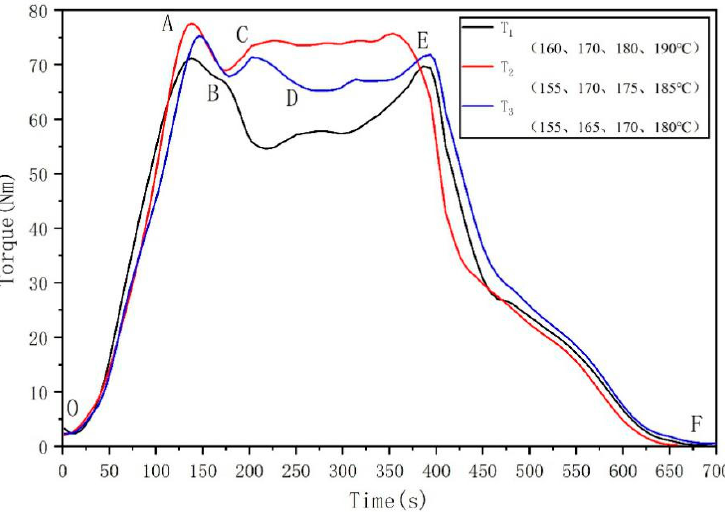
Figure 4. The influence of temperature on the extrusion torque change. OA section: When solid material is added, the torque increases rapidly. AB section: The material is compressed, and the torque drops to point B. BC section: The material begins to soften or melt, and the torque rises to point C. CD section: The material continuously and completely melts under the action of heat and shear, the fluidity is enhanced, the viscosity is reduced, the force of screw on the material is reduced, and the torque is reduced to point D. DE segment: The torque tends to be stable and is maintained near the E point. EF section: With the decrease in material, the torque gradually drops to zero.